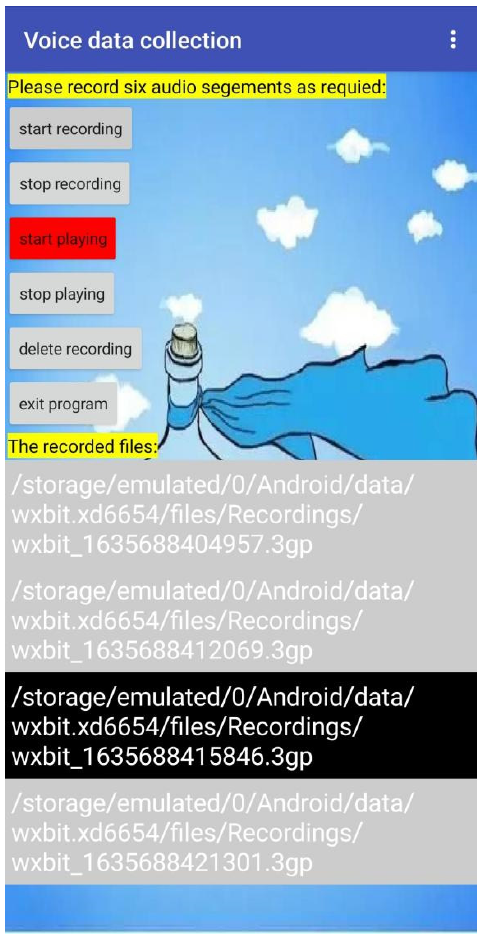
Figure 4. Voice data acquisition and management app.